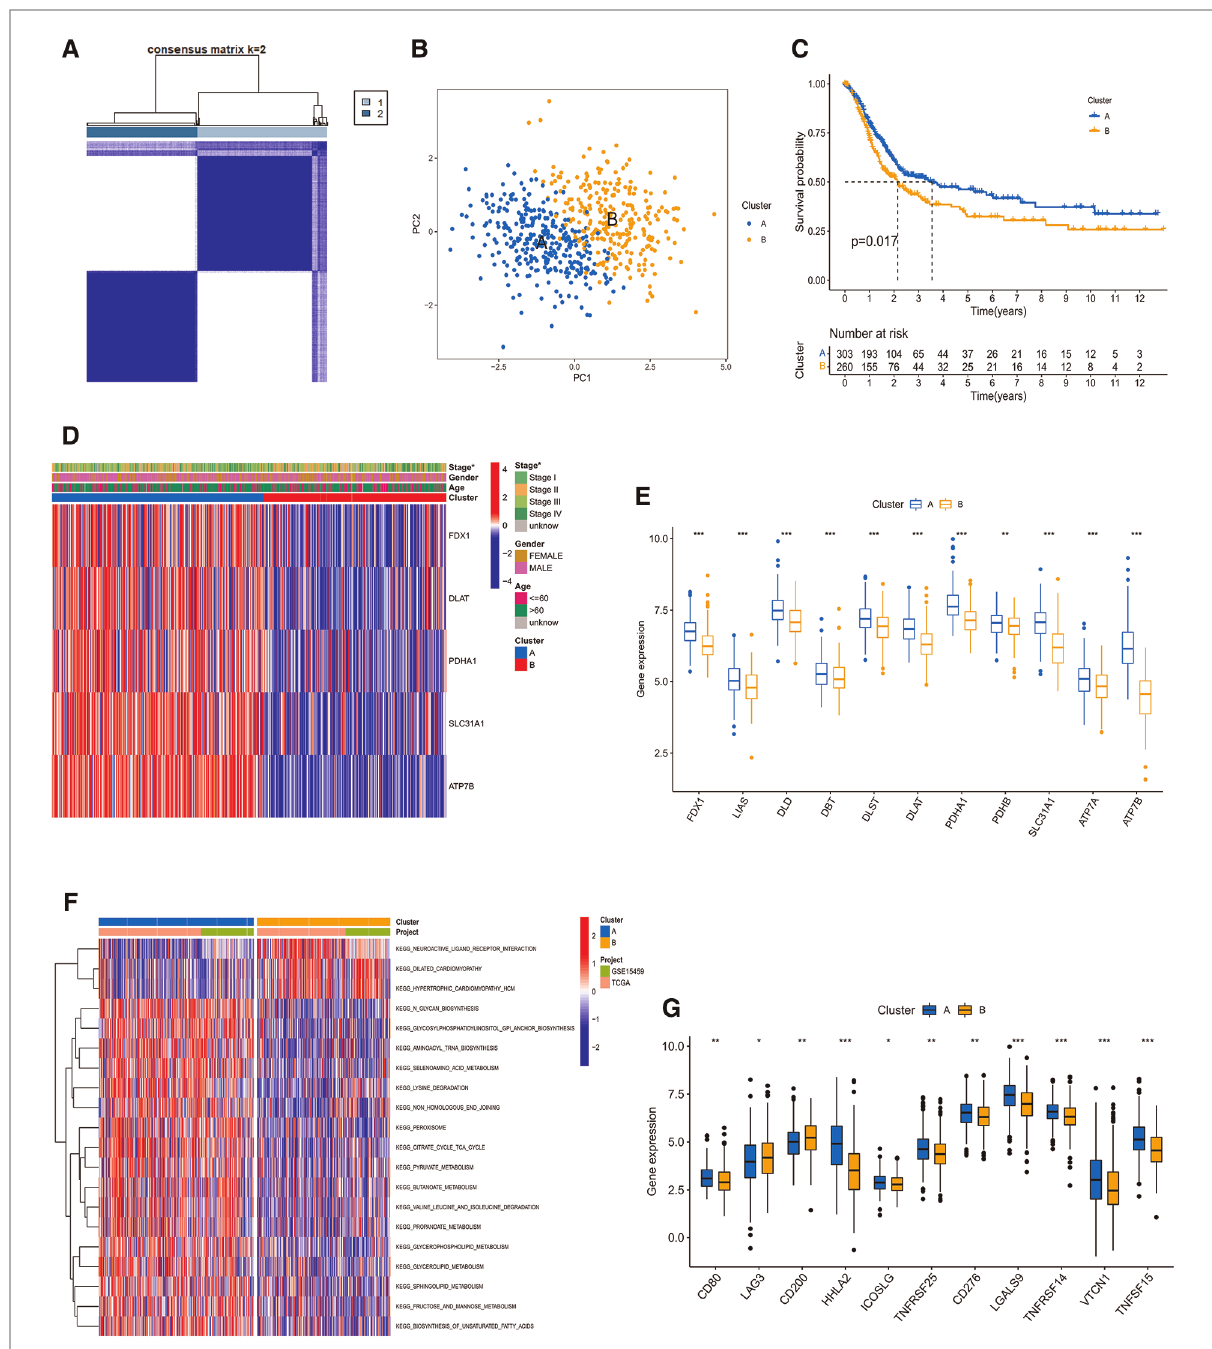
FIGURE 3 ( A ) consensus clustering matrix de fi ning two clusters ( k =2). ( B ) The PCA analysis of the two clusters describing an obvious difference. ( C ) The KM curve between A and B subtypes. ( D ) The heatmap showing the correlation of the two subtypes with age, stage, gender, and CRGs. ( E ) The mRNA expression of CRGs between A and B subtypes. PPI, Protein-protein interaction; KM, Kaplan – Meier. ( F ) GSVA of analysis between two distinct subtypes, in which red represents positively correlated pathways and blue negatively correlated pathways. ( G ) Differential expression of immune checkpoints in the two